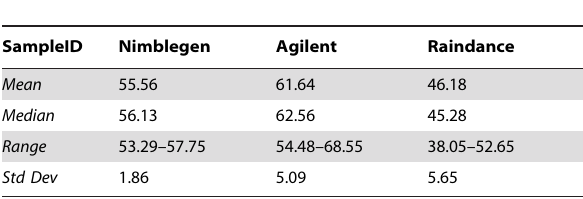
Table 4. Percent on-target, unmatched sample sets (N= 6).